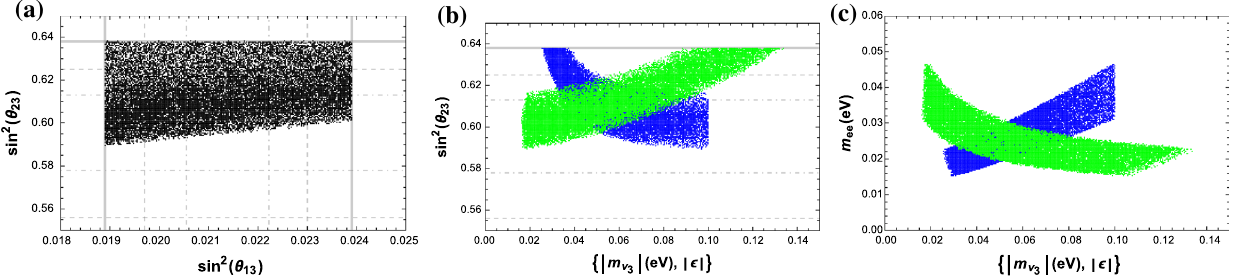
| and | (cid:17) | , and c m | m 0 | and | (cid:17) | . Inverted hierarchy: blue ν 3 ee versus 3